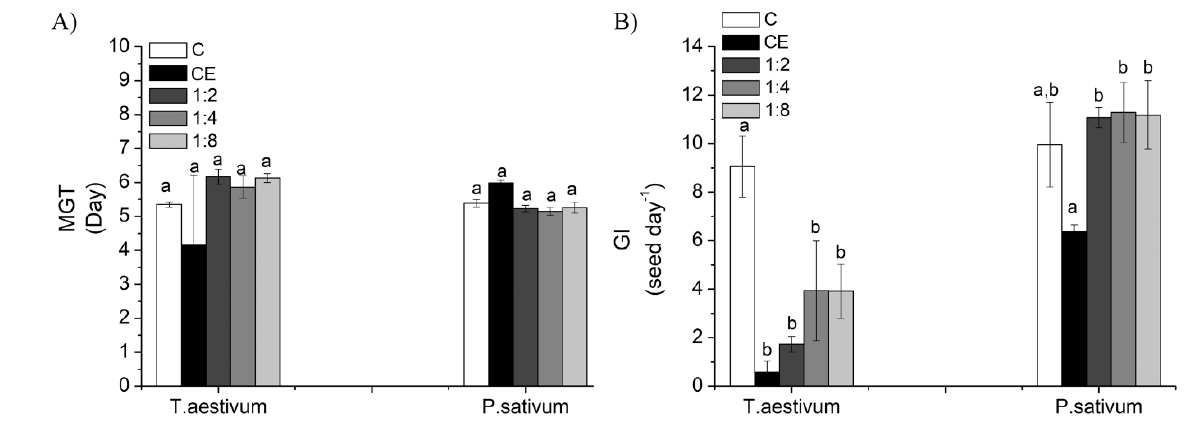
Figure 3. Mean germination time (MGT) (A) and germination index (GI) (B) of the tested species in the control and at different concentrations of walnut leaf aqueous extract . Different lower case letters a, b , indicate a statistically significant difference between treatments of one test species (p